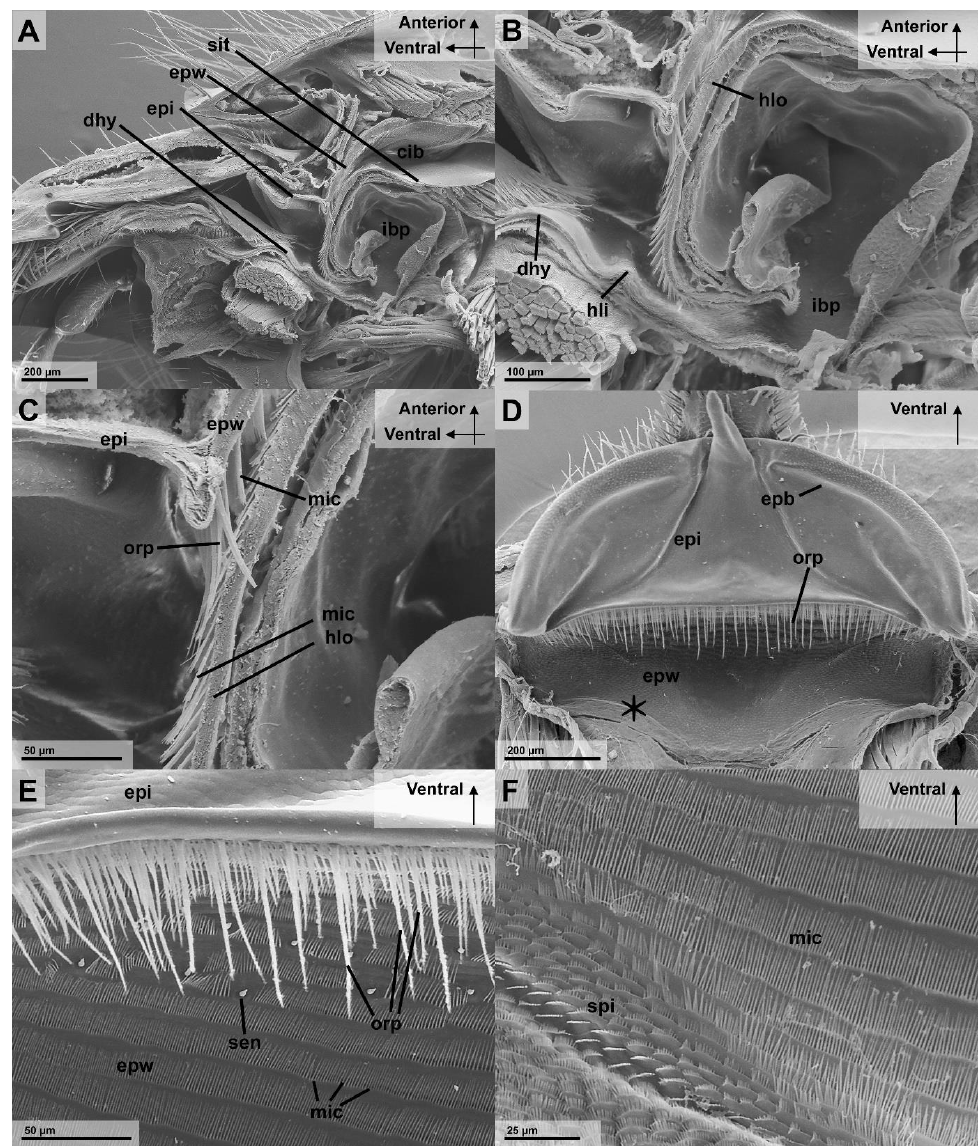
Figure 5. The preoral filtering structures inside the head of Vespula germanica, focused on the parts of the ephipharyngeal wall (including the epipharynx) (SEM). ( A ) The anterior parts of the head in a sagittal cut. The preoral cavity and the functional mouth opening (at the oral pecten) is visible. ( B ) The detail of the infrabuccal pocket in a sagittal cut. ( C ) The detail of the arrangement of microtrichia and the oral pecten at the functional mouth opening, lateral view. ( D ) The overview of the epipharynx and epipharyngeal wall, viewed from the posterior-ventral side. ( E ) The detail of the oral pecten from the posterior-ventral view. ( F ) The detail of the surface structure of the posterior epipharyngeal wall, with the cuticula structures changing from hair-like microtrichia to the spine-like microtrichia, at the funnel-shaped lateral groove, marked in ( D ) with an asterisk, viewed from posterior-ventral [Abbreviations: cib: cibarium, dhy: dorsal hypopharynx, epb: epipharyngeal bar, epi: epipharynx, epw: epipharyngeal wall, hli: hypopharyngeal lip, hlo: hypopharyngeal lobe, ibp: infrabuccal pocket, mic: microtrichia, orp: oral pecten, sen: sensillae, spi: spine-like microtrichia].